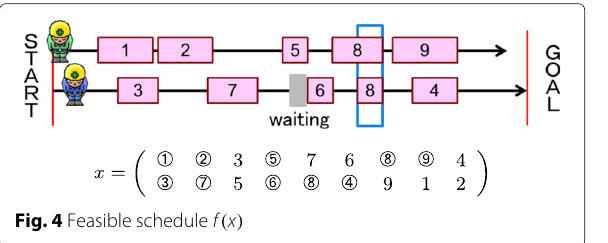
Algorithm 2: Subroutine for updating t